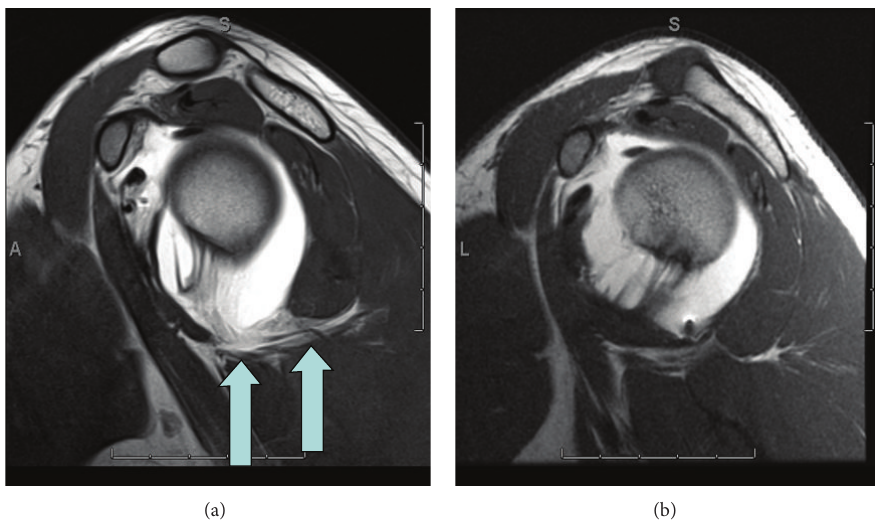
Figure 4: Case 9. Oblique sagittal T1 before and after HAGL repair: (a) prerepair shows contrast/fluid in quadrilateral space. (b) shows no extra-articular extravasation 2 years after repair. The intermuscular distance between the teres major and teres minor is increased on (a) (arrows) with an apparent gap at the axillary pouch in this area, which is no longer seen after